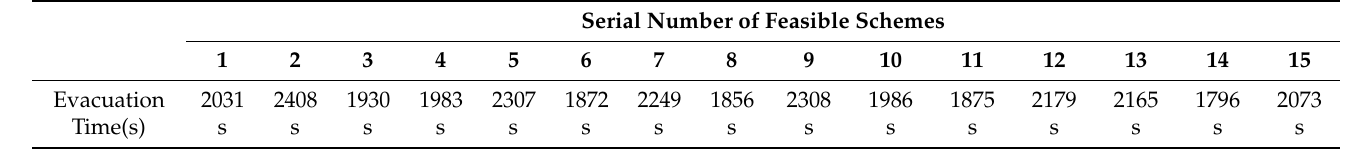
Figure 9. The optimal shelter location scheme.